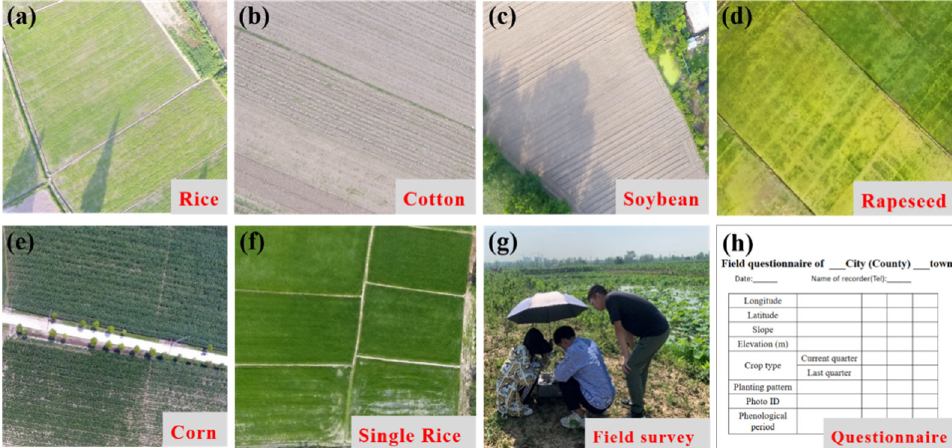
Figure 3. ( a – f ): Field images based on UAV observations and ( g , h ) photos of adjusting the UAV in the field and the field survey questionnaire.